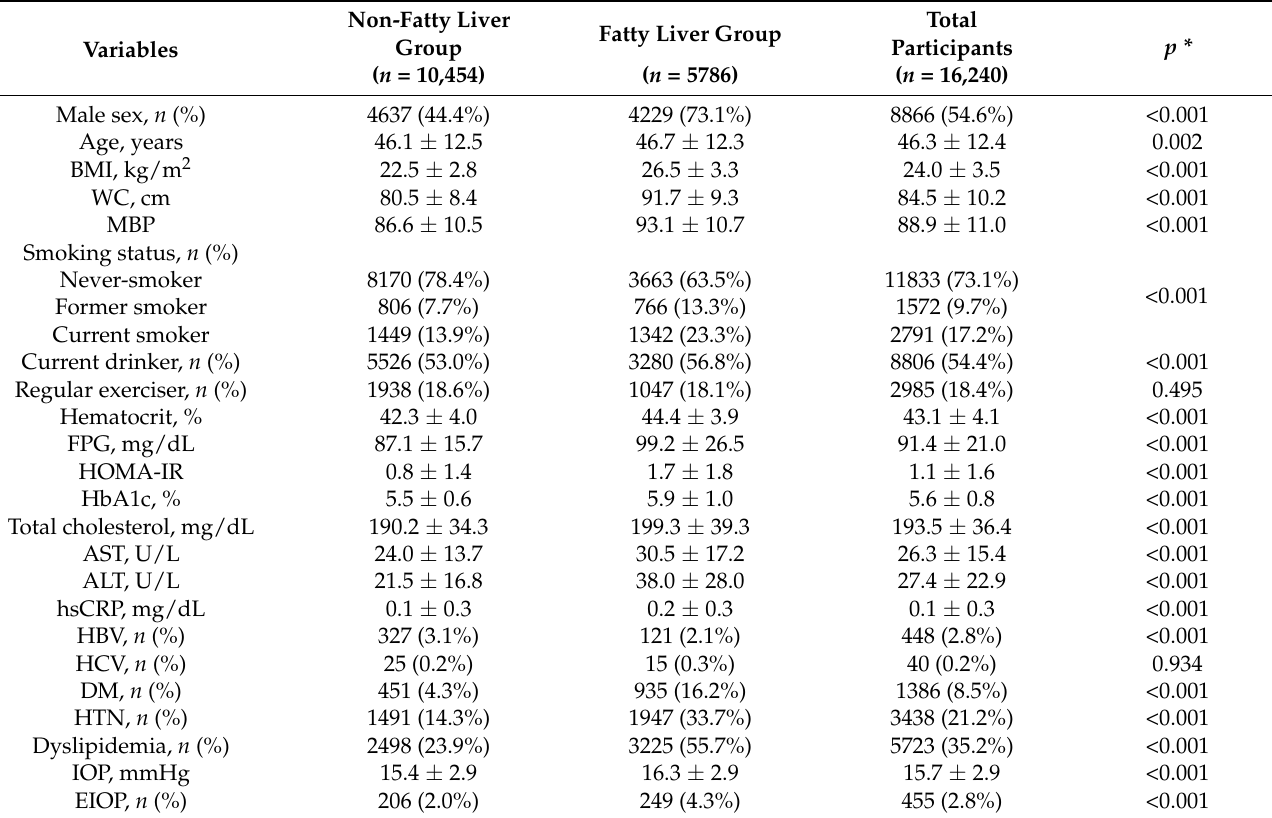
Table 1. Clinical characteristics of the study